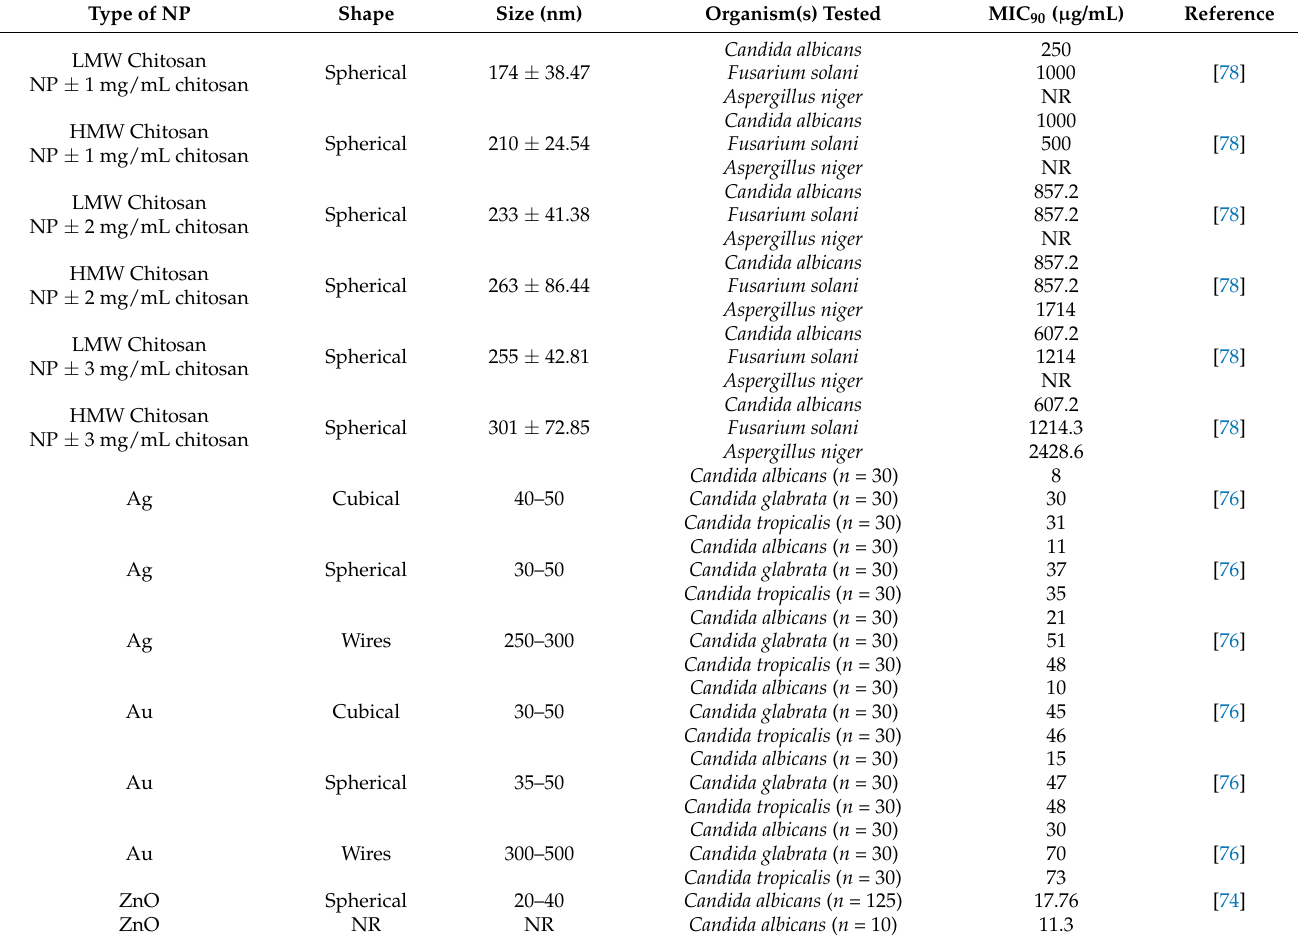
Figure 4. Different types of metallic NPs developed against fungi. Table 4. Activities of NPs tested on different fungal species expressed as MIC 90 ( µ